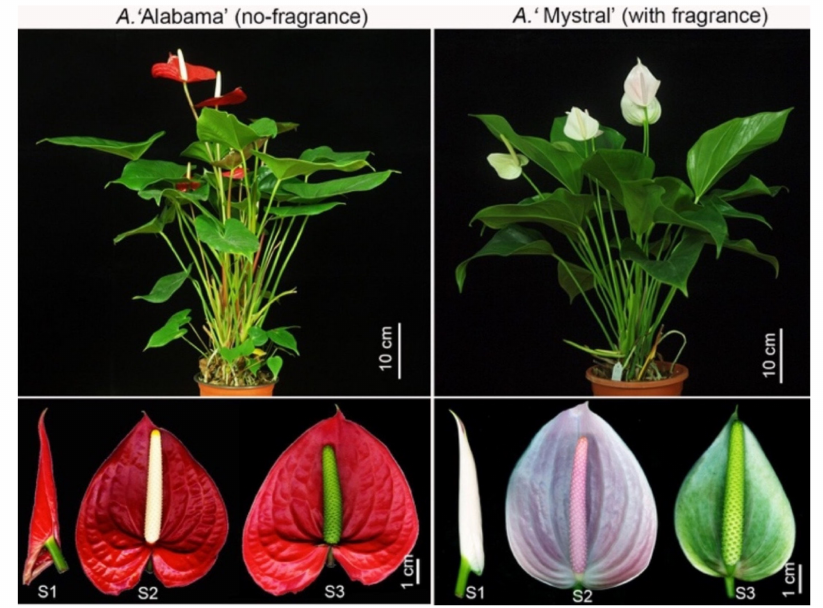
Figure 2. Phenotype of A. ‘Alabama’ and A. ‘ Mystral ’. S1, spathe folding stage; S2, pistillate emerge stage; S3, spadix fully extended